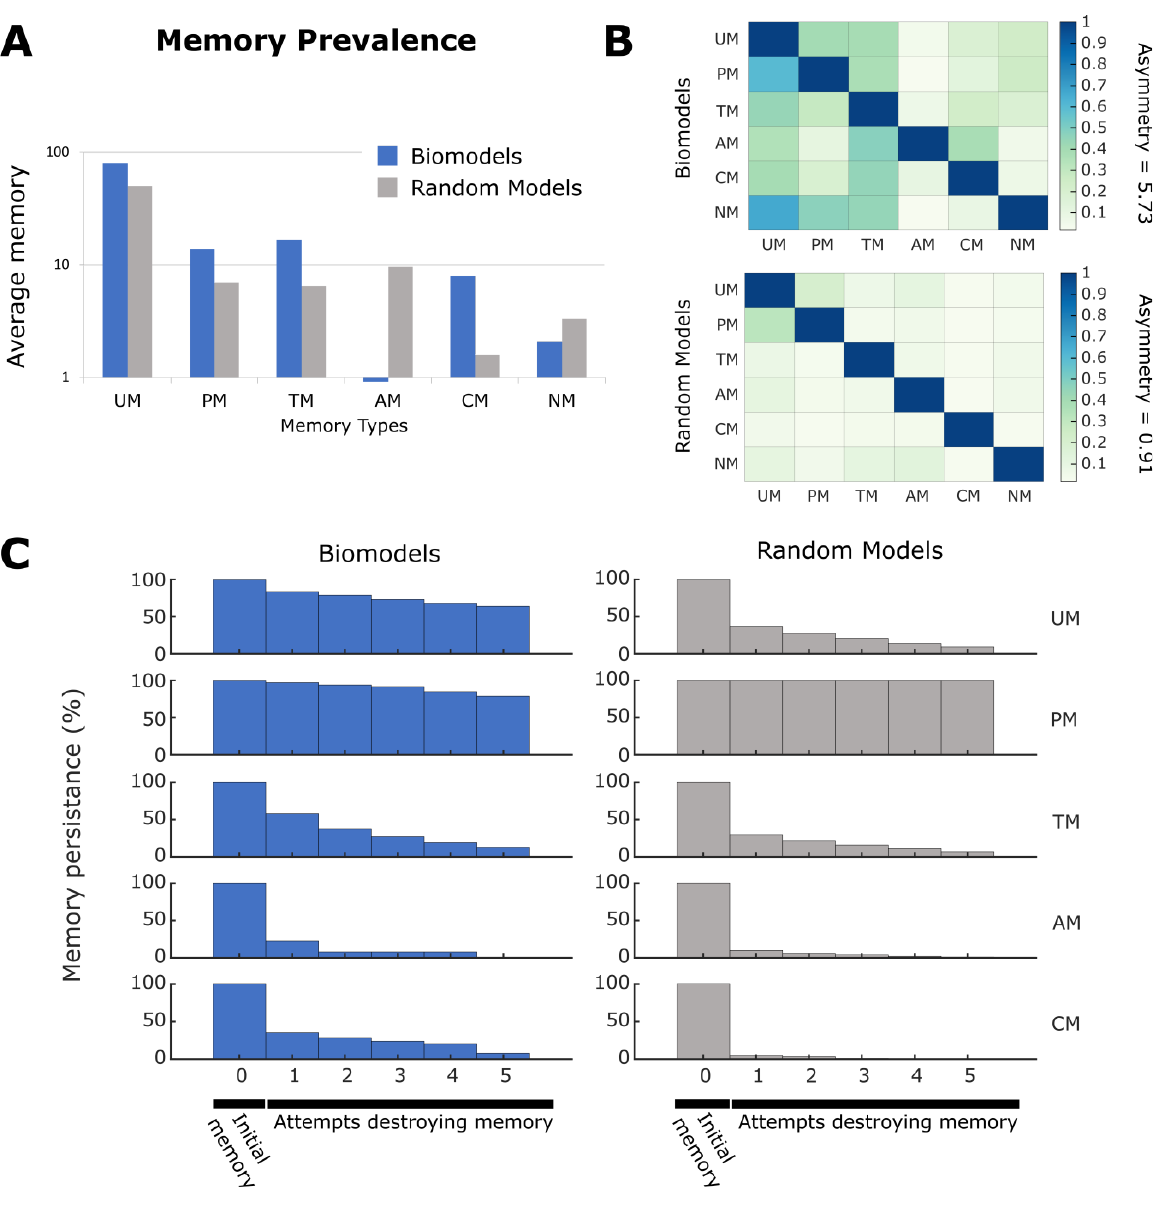
Figure 7. Biological models have unique memory properties as compared to random models.